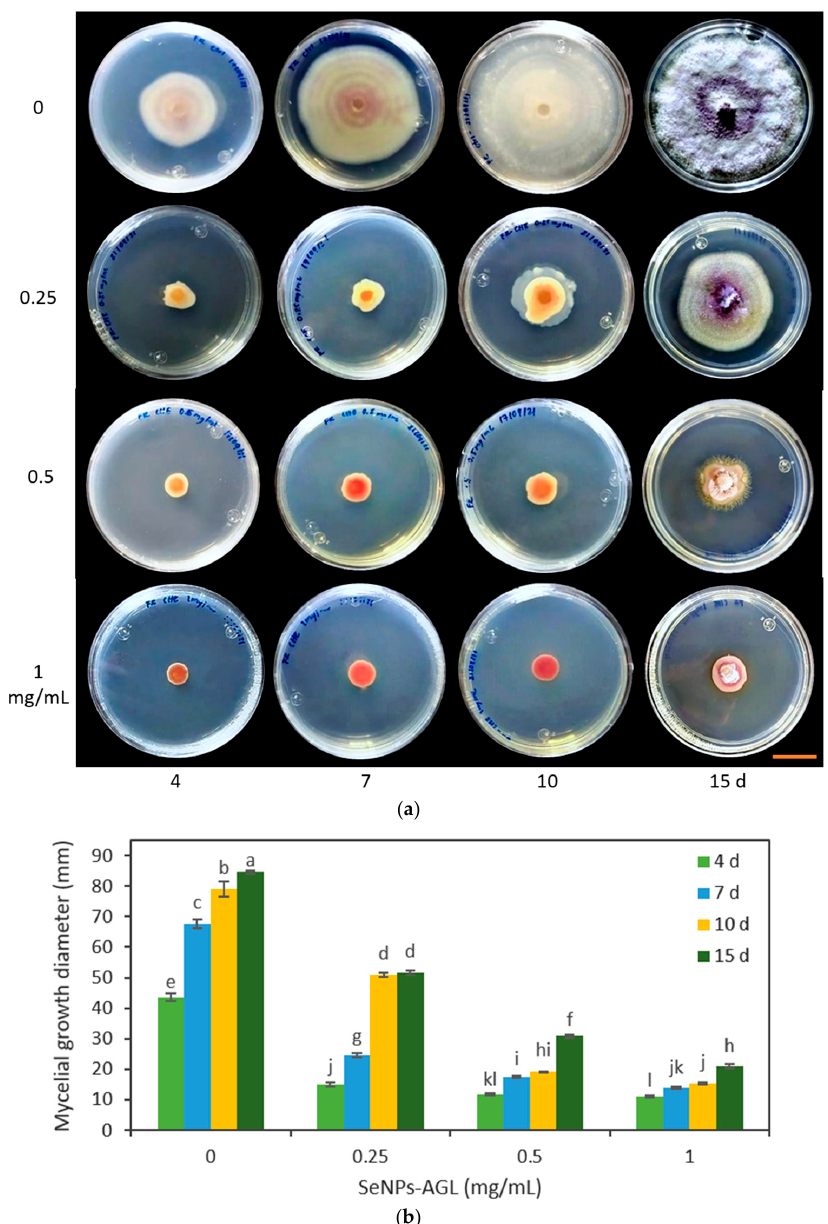
Figure 8. Effect of different concentrations of SeNPs synthesized with A. glaucum (AGL) extracts against F. oxysporum . ( a ) Representative photograph of the antifungal activity test under different concentrations over time. SeNPs were applied at 0.25, 0.5, and 1 mg/mL. The scale bar is 2.5 cm. ( b ) Mean comparison of the effect of the SeNPs synthesized with extracts of A. glaucum against F. oxysporum at different concentrations. Mean values ± ee. Different letters indicate statistically significant differences according to Duncan’s test ( α = 0.05), p < 0.0001.